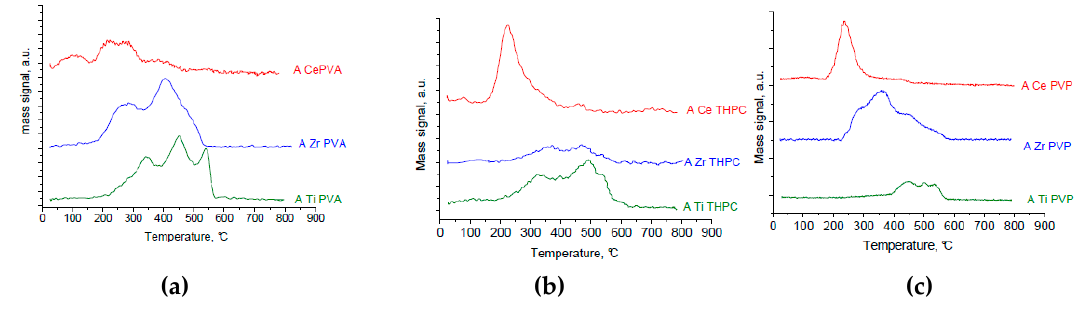
Figure 7. TPO analysis (m/e = 44) for samples synthesized by PVA (section a ), THPC (section b ), PVP (section c ).